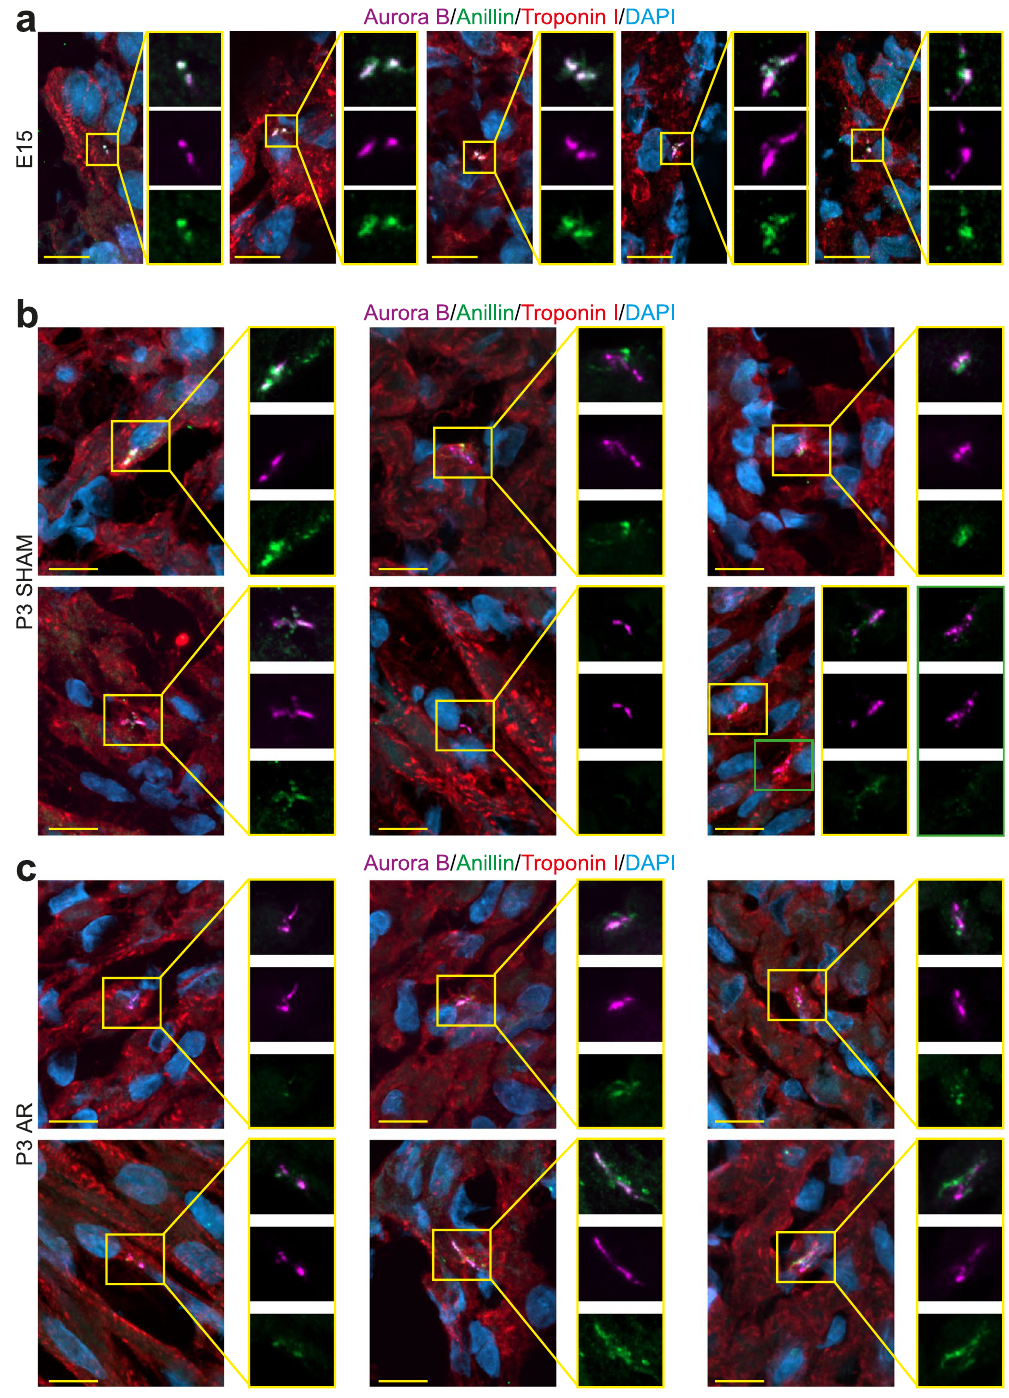
Figure 4. Characterization of cardiomyocyte cytokinesis in vivo . Representative images of rat heart sections stained for cytokinesis proteins Aurora B (purple) and Anillin (green) and cardiomyocytes (Troponin I, red). Nuclei were visualized with DAPI (blue). ( a – c ) Representative images of cardiomyocytes undergoing midbody formation in hearts from E15 ( a ) cytokinesis results in cell division), P3 SHAM ( b ) cytokinesis results in binucleation) and P3 post-AR ( c ) rats. Scale bars: 10 µ